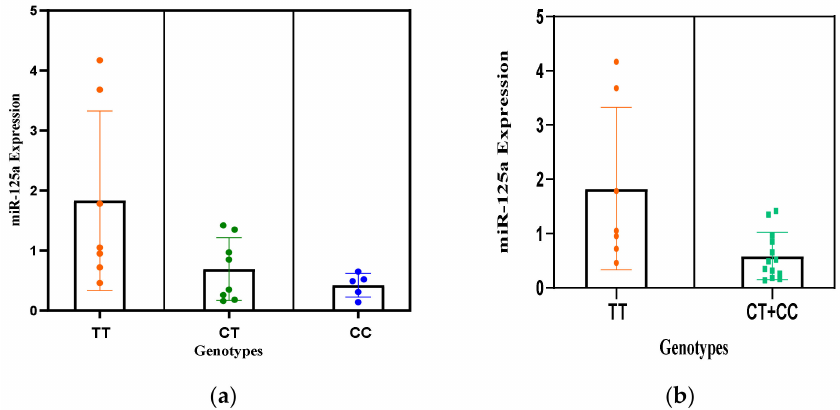
Figure 5. Scatter plot for miR-125a expression levels in association with the genotypes of miR-125a rs12976445 C/T polymorphism. ( a ) miR-125a expression levels with each genotype of miR-125a rs12976445 where TT represents wild genotype, CT heterozygous and CC homozygous mutant. ( b ) miR-125a expression levels with respect to TT vs. combined genotype CT+